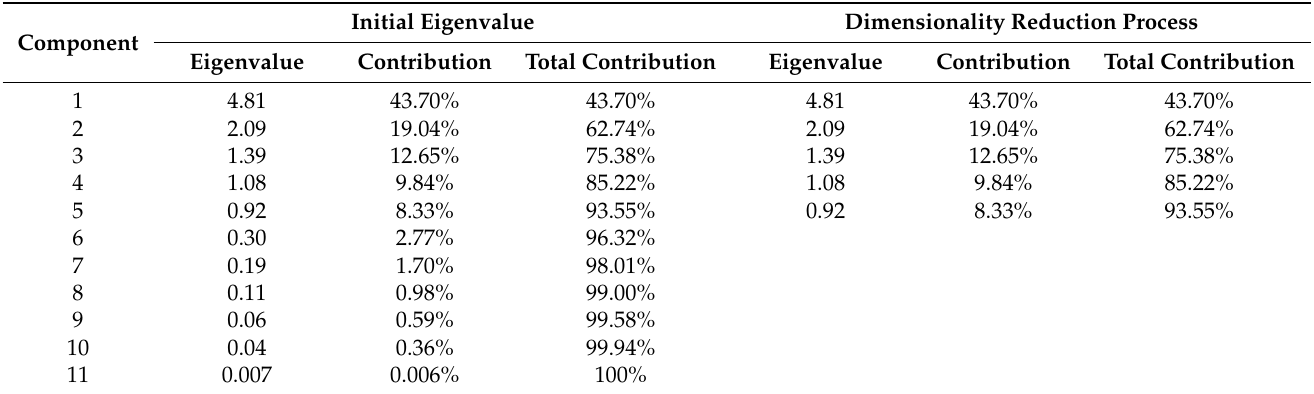
Table 7. Eigenvalues and contributions of principal components of characteristic target